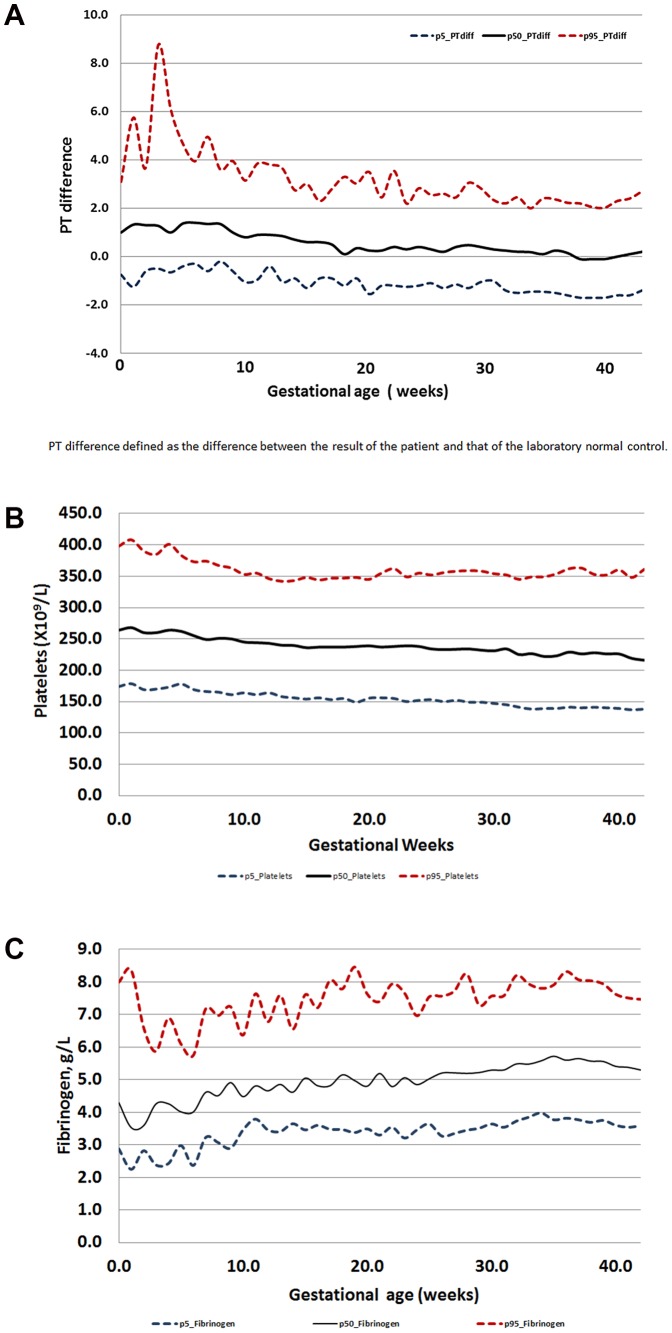
The changes in the major components of the pregnancy modified DIC score: a)- PT- difference; b)- platelets; and c)- fibrinogen, with advancing gestations.